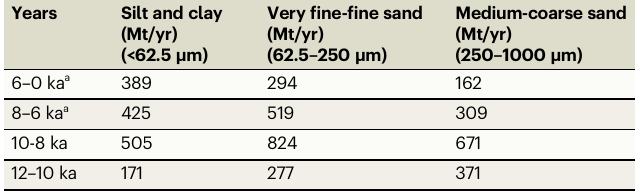
Table 1 | Average mass storage rates and grain-size distribu- tions for deposits stored on the Ganges – Brahmaputra delta over the last 12